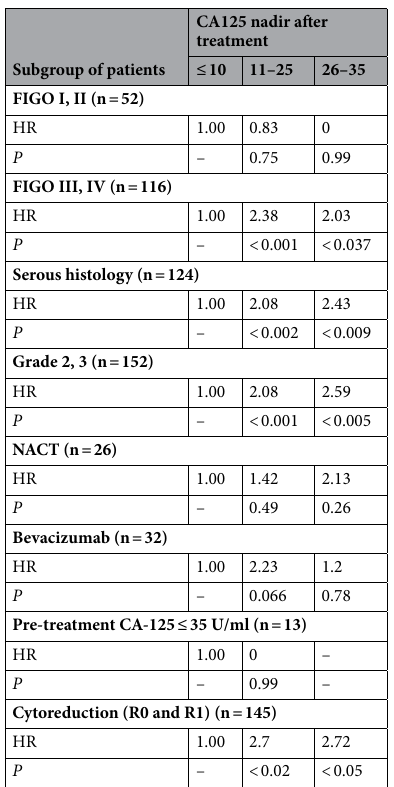
Table 3. Risk of relapse and the CA-125 nadir after treatment in subgroups of